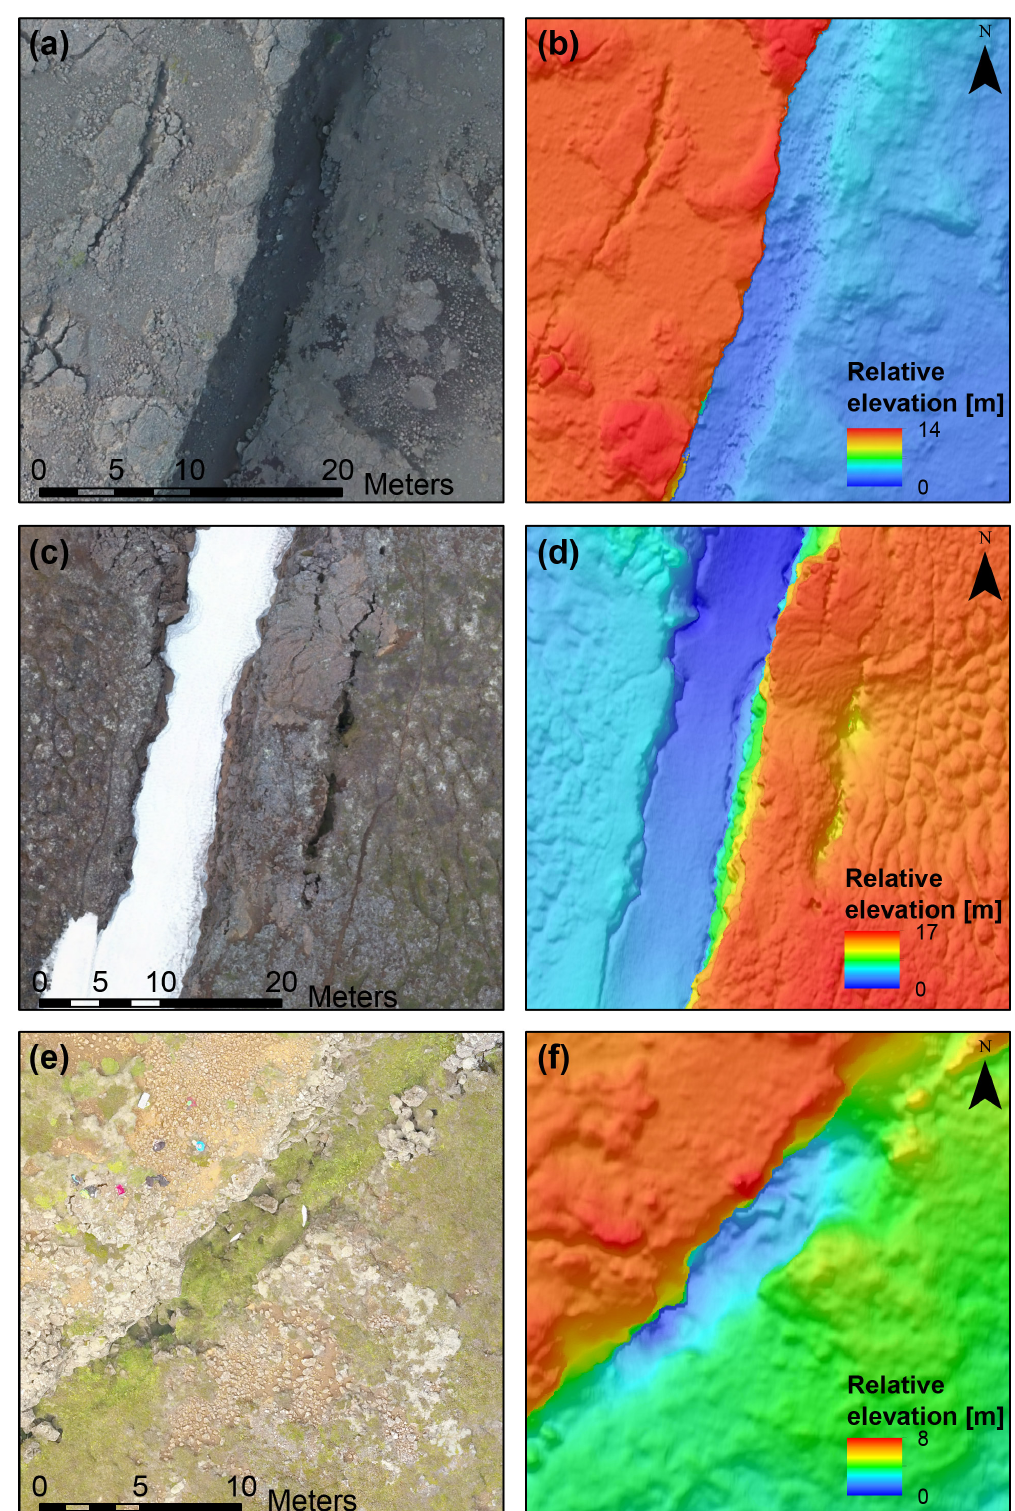
Figure 14. Samples showing the resolution of our DEMs and orthomosaics on dilatant faults: (a, c, e) orthorectified mosaics and (b, d, f) DEMs. (a, b) Theistareykir; the opening is not yet completely filled by sediment; 65 ◦ 50 (cid:48) 50 (cid:48)(cid:48) N, 17 ◦ 0 (cid:48) 19 (cid:48)(cid:48) W. (c, d) Krafla; the opening is partly and temporarily filled by ice; 65 ◦ 51 (cid:48) 17 (cid:48)(cid:48) N, 16 ◦ 43 (cid:48) 23 (cid:48)(cid:48) W. (e, f) Vogar; the opening is partly filed by rubble and vegetation; strong erosion is apparent; 63 ◦ 58 (cid:48) 5 (cid:48)(cid:48) N, 22 ◦ 21 (cid:48) 16 (cid:48)(cid:48) W. Projection: WGS1984 UTM 27N and 28N. Solid Earth, 10, 1757–1784, 2019